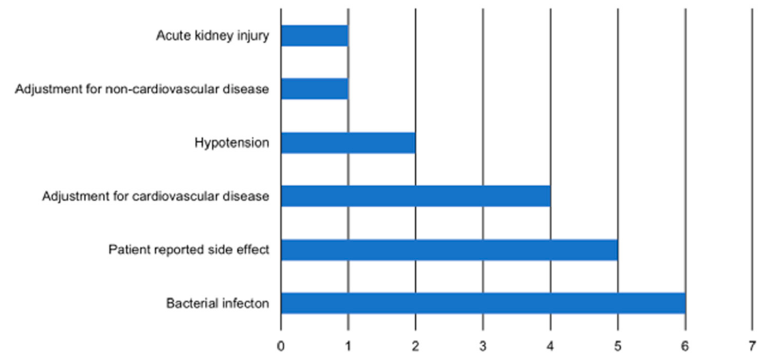
Figure 2. Reasons for discontinuation of SGLT2 inhibitors ( n = 19).